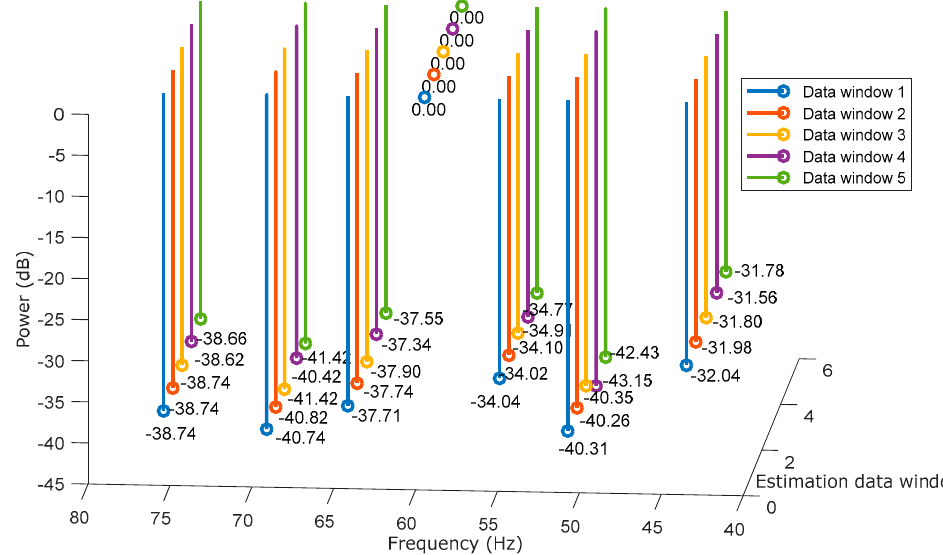
Figure 19. Prony estimated periodogram at 60 Hz frequency speed operation scenario.